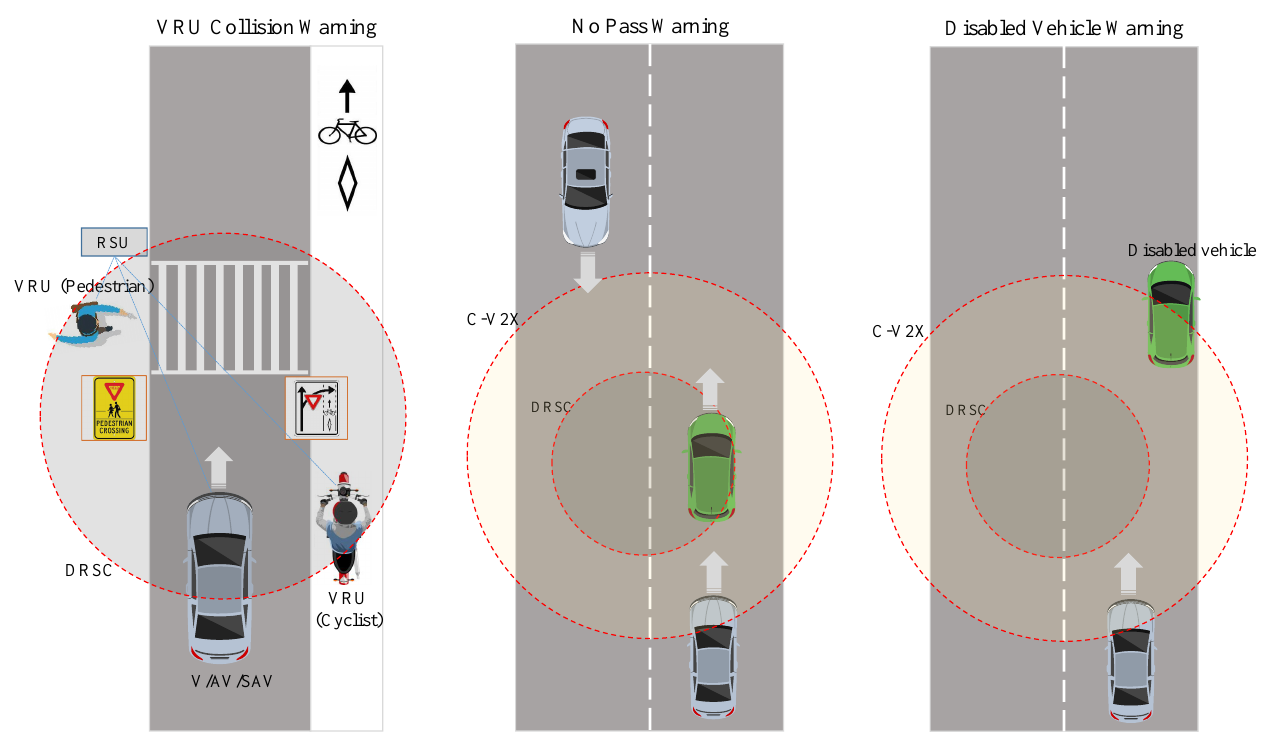
Figure 2. VRU Collision warning, no-pass warning, and disabled-vehicle